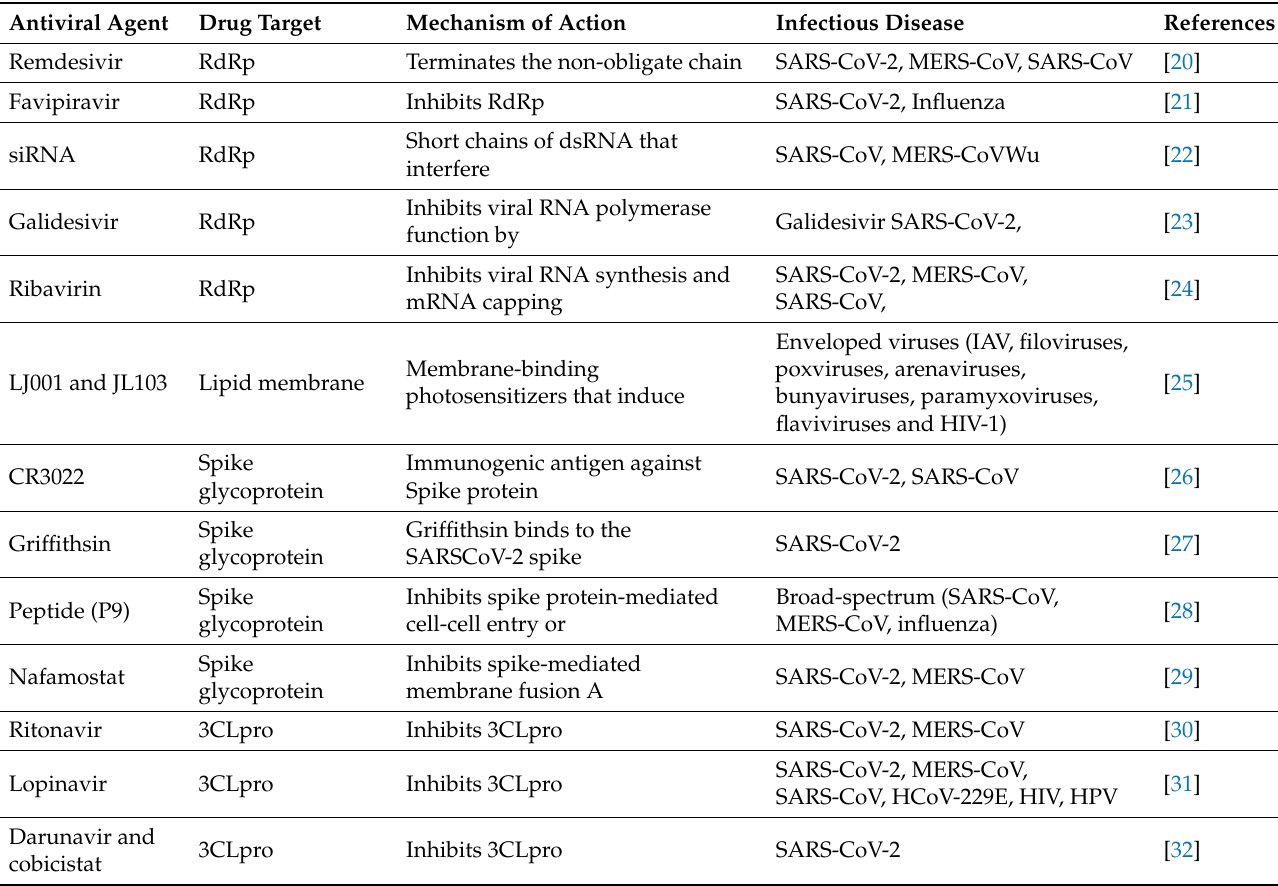
Table 1. Virus-based therapy: Drugs capable of attacking nucleotides, nucleosides, or viral nucleic acids of a broad range of coronaviruses and other